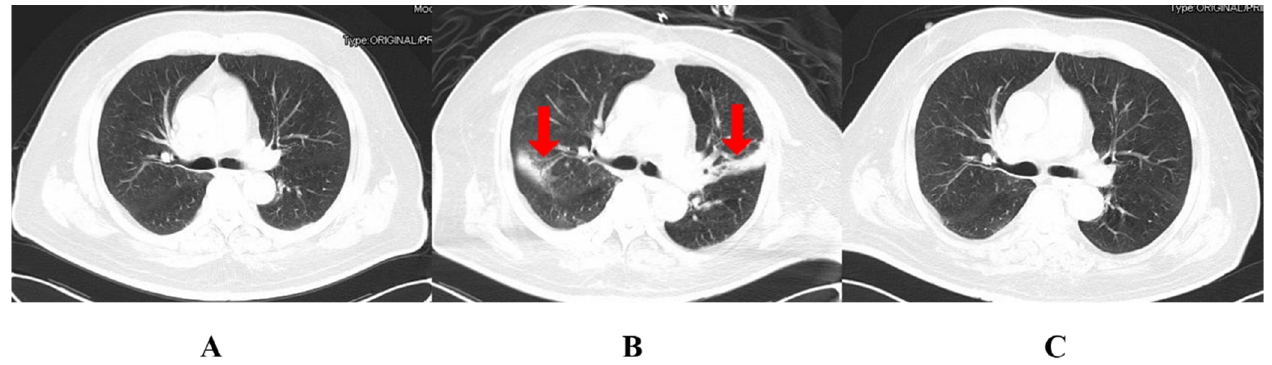
Figure 2. The CT of the chest during the patient’s hospital stay. ( A ): the Chest CT on 8 February (two days before surgery); ( B ): the Chest CT on 4 March (day 22); ( C ): the Chest CT on 22 April (day 71). The areas indicated by the red arrows are the sites of infection.